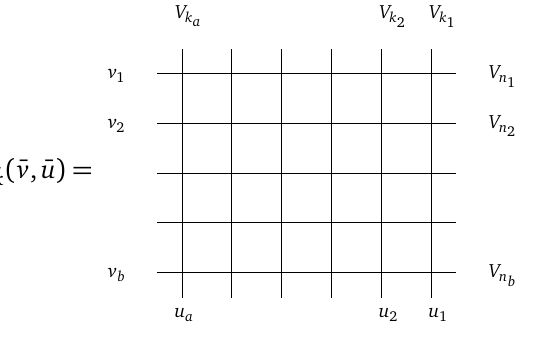
Figure 4: Graphical interpretation of (cid:82)